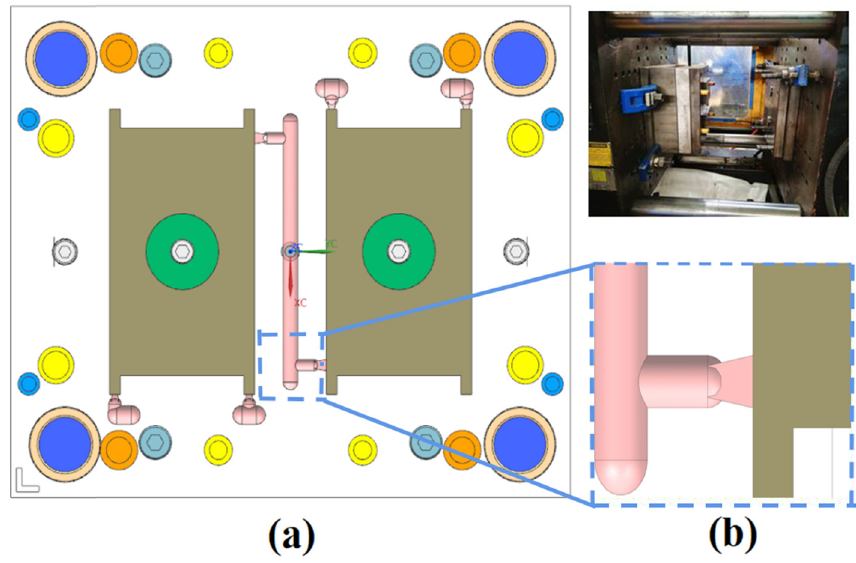
Figure 2: Injection mold: ( a ) Layout and ( b ) Gate.